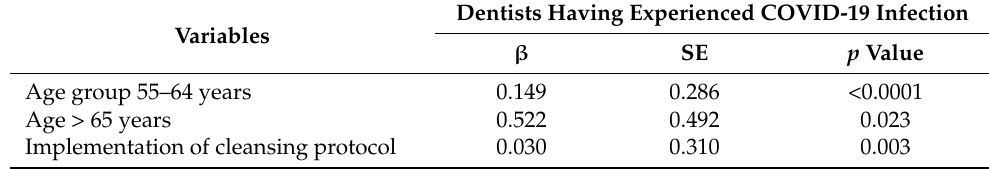
Table 3. Stepwise binary logistic regression of variables associated with COVID-19 infection